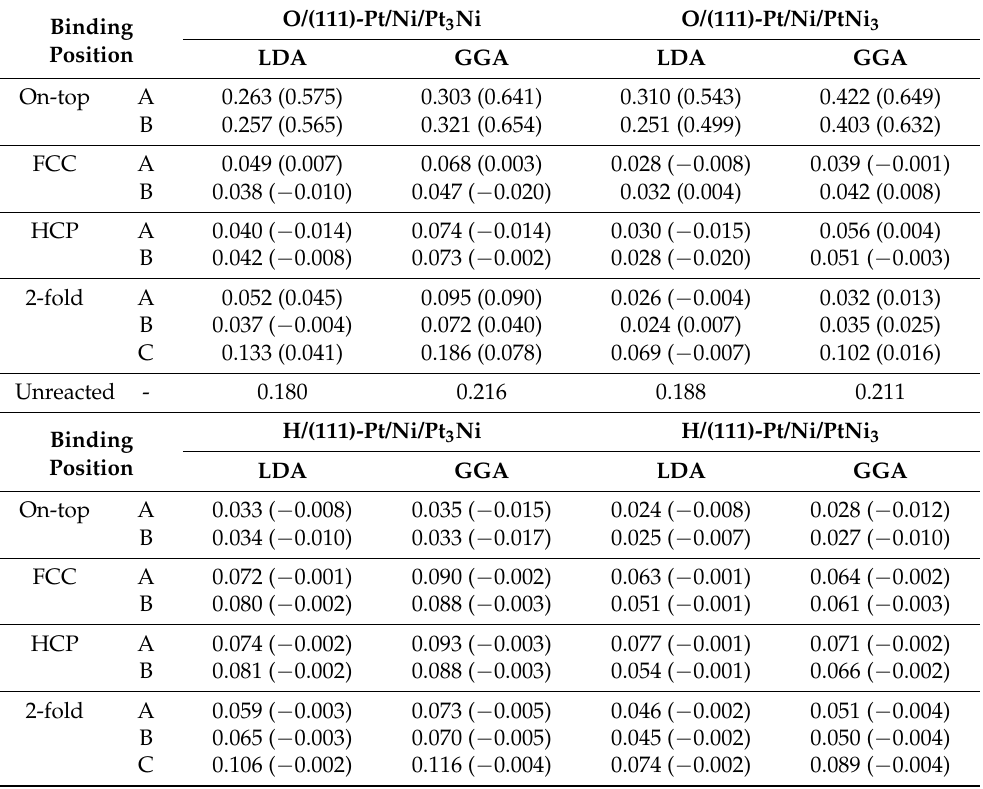
Table 8. Magnetisation of the surface Pt atoms on the oxygen and hydrogen reacted and clean (111)-Pt/Ni/Pt 3 Ni and (111)-Pt/Ni/PtNi 3 surfaces. For the reacted surfaces, the Pt atoms are the nearest neighbours to either the O or the H adsorbate. The binding positions are defined in Figure 14, and the column subheadings (‘LDA’/‘GGA’) indicate the exchange-correlation functional used. The numbers in brackets shown are the magnetic moments of the adsorbate. All magnetic moments in these tables are in units of µ B